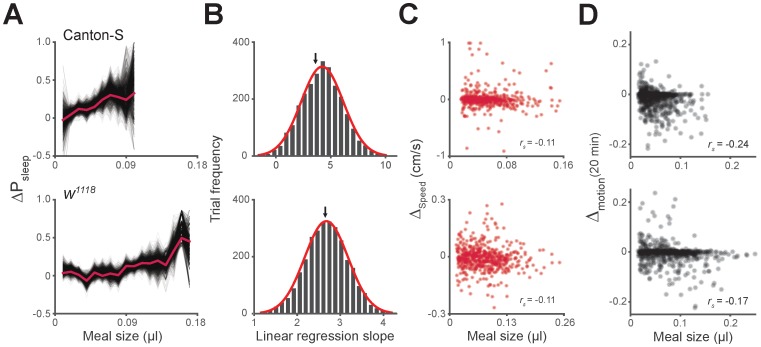
Unequal meal sampling frequency and motor ability effects on meal size-sleep correlation.(A) Monte Carlo simulation of ΔPsleep as a function of meal size using fixed sampling frequency from individual flies. Simulations contained 3000 trials of randomly sampled meals, where thin black lines represent individual trials, and the red line represents the entire data set (three samples/fly, Canton-S; eight samples/fly, w1118; 0.01 µl meal groupings). (B) Histogram of linear regression slope for each trial fit with a Gaussian distribution (red line). The black arrow indicates the slope value of the entire data set. (C) Average Δspeed for the 20 min relative to meals versus meal size (Spearman rank-order correlation: p=0.0096, Canton-S; p=0.0095, w1118).